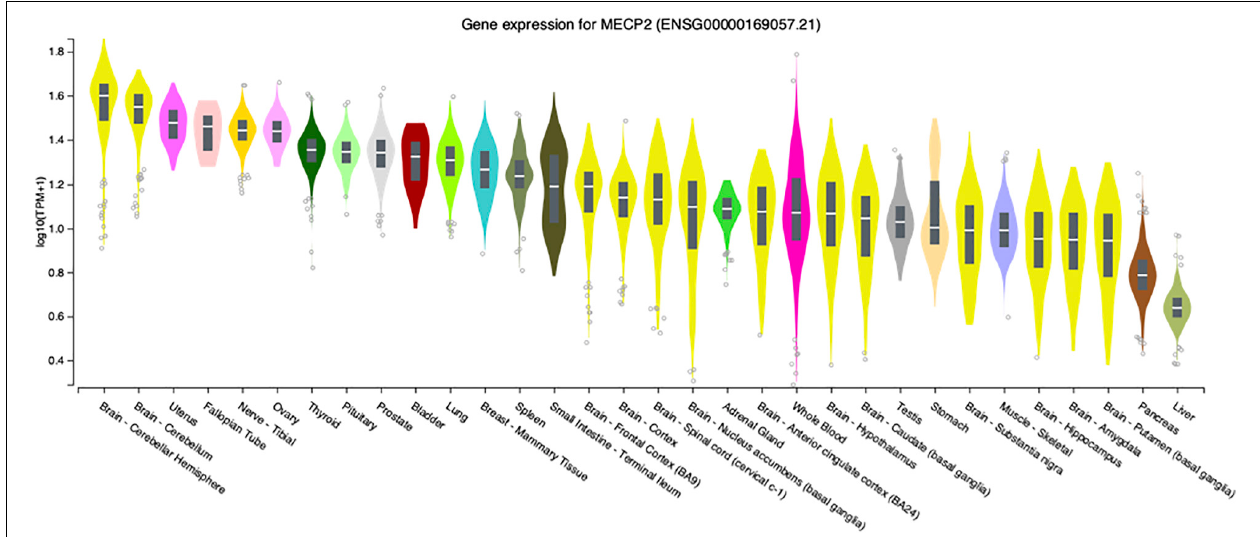
FIGURE 1 | MECP2 transcript levels in select human tissues. Violin plots from the Genome-Tissue expression (GTEx) project are shown for MECP2 with log2 values ranked from high to low